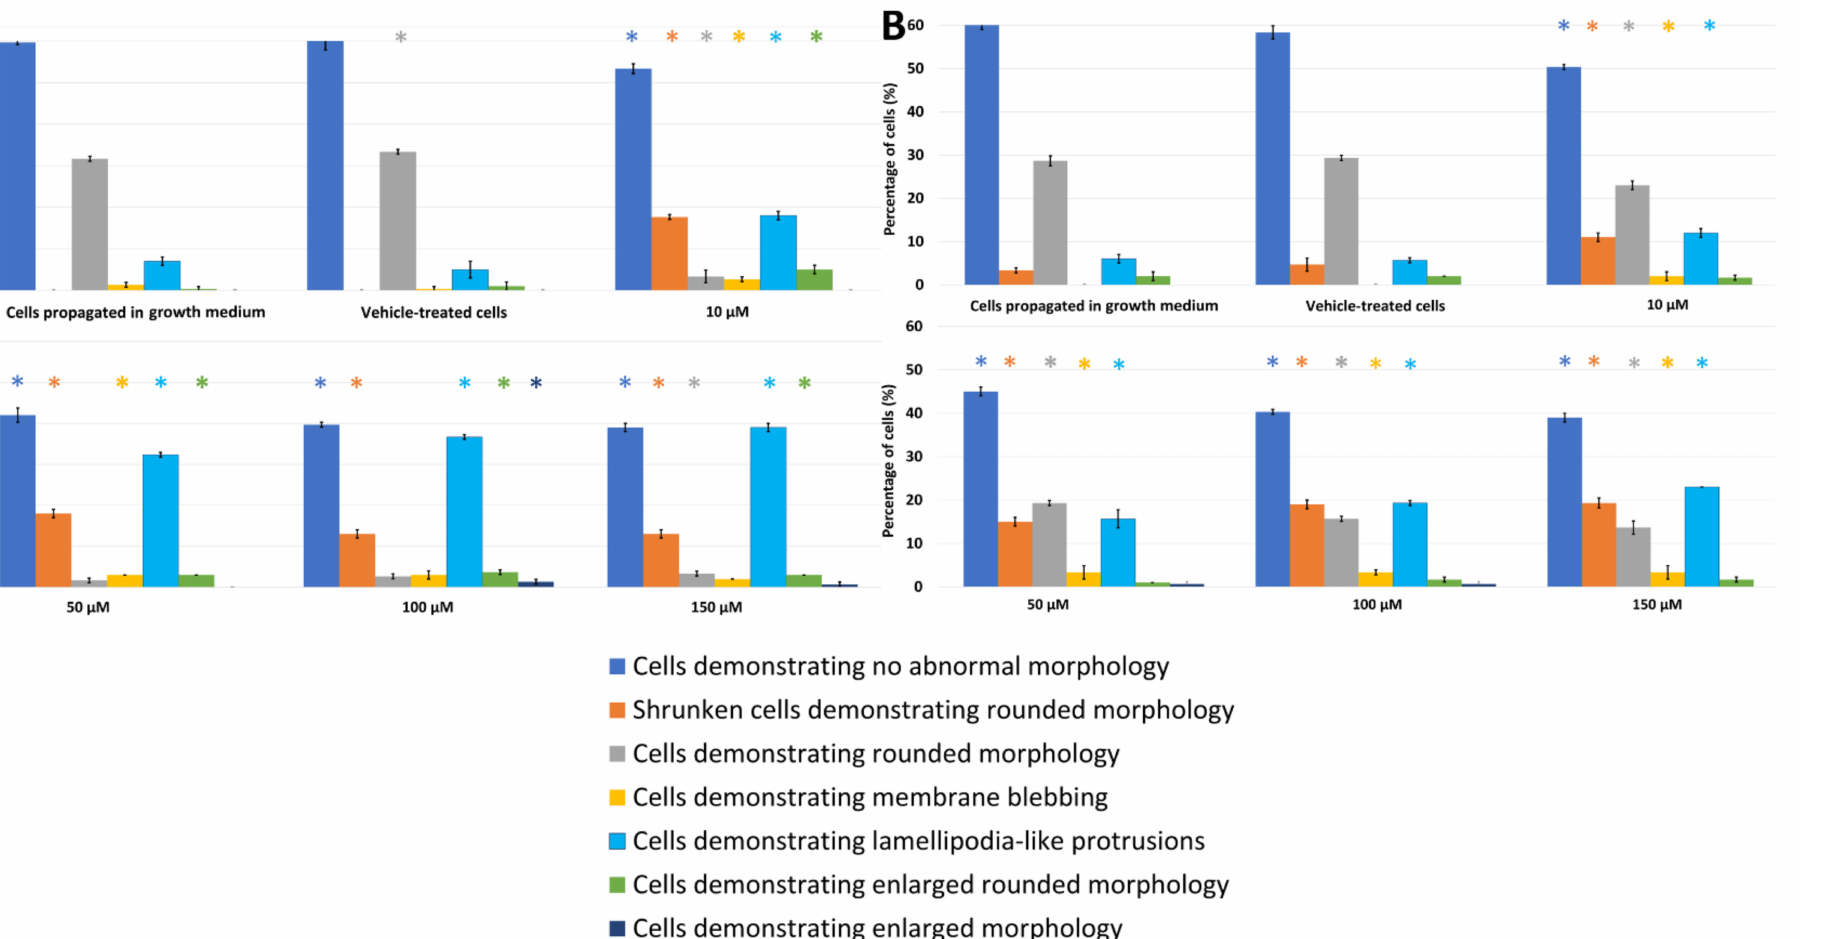
Figure 3. Light microscopy results demonstrating the effects of PPV (10–150 µ M) on cell morphology on A549 cells at 48 h ( A ) and 72 h ( B ). Statistical significance is represented by an * when using the Student t-test with a p value of 0.05 compared to cells propagated in growth